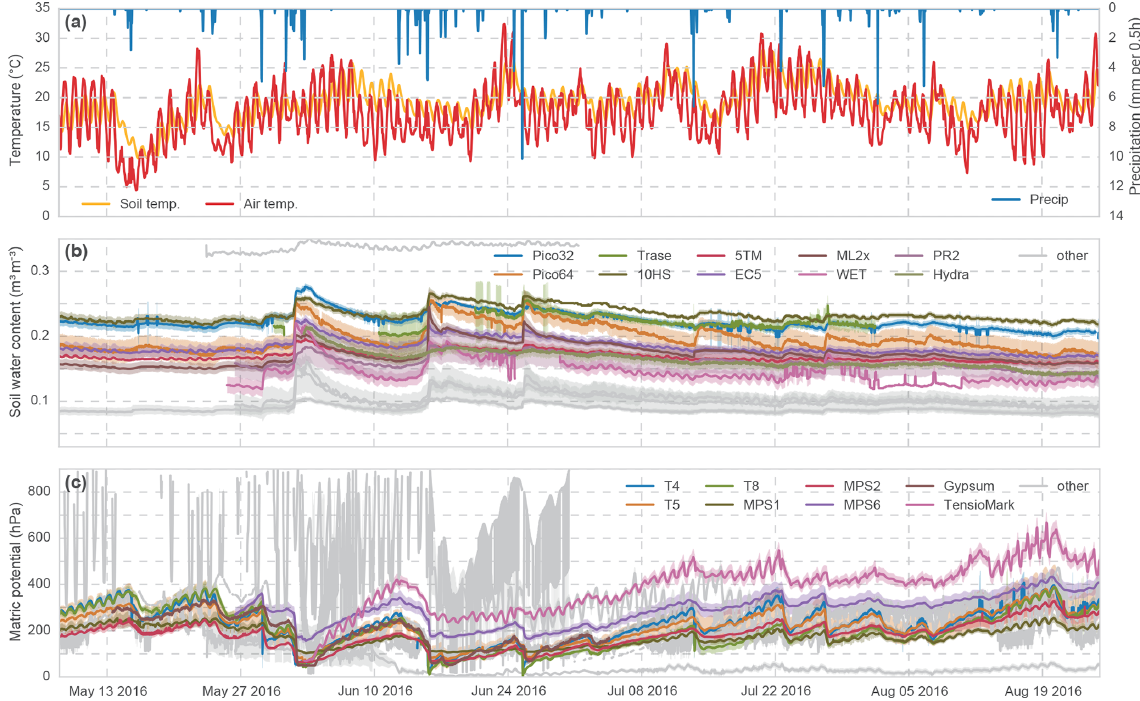
Figure 4. (a) Meteorological forcing (DWD station 662), (b) volumetric soil water content dynamics and (c) matric potential; 30min median of all sensors of a system as solid line, and variance is shaded. Sensor systems with non-plausible oscillations and value ranges are given as “other”.